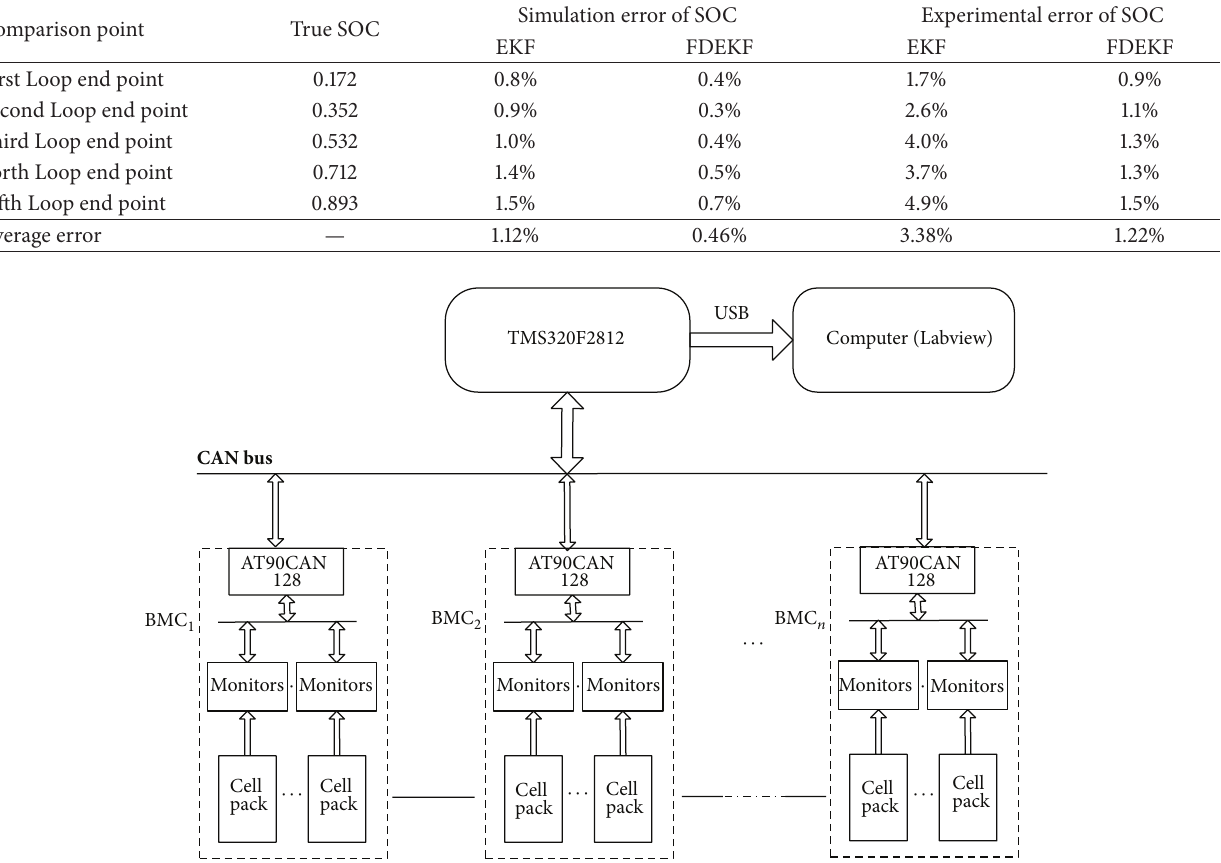
Figure 10: The extended structure